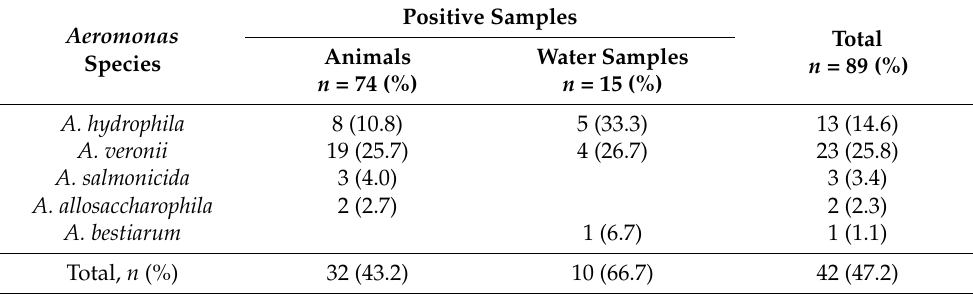
Table 1. Prevalence of Aeromonas species in turtles and water samples.